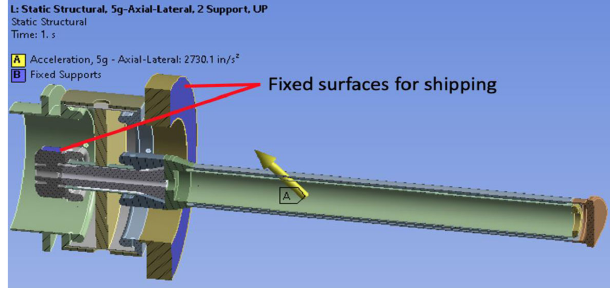
FIG. 11. Mechanical simulation boundary condition.